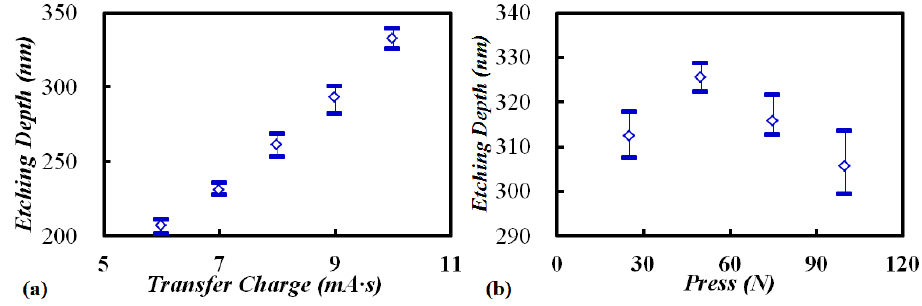
Figure 11. Etching depths as a function of: ( a ) transfer charge; ( b ) applied press in TEM.